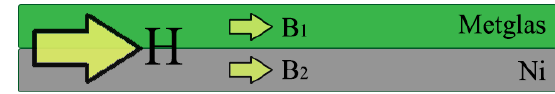
Figure A1. Intrinsic magnetic fields in the bilayer magnetostrictive structure Ni/Metglas.